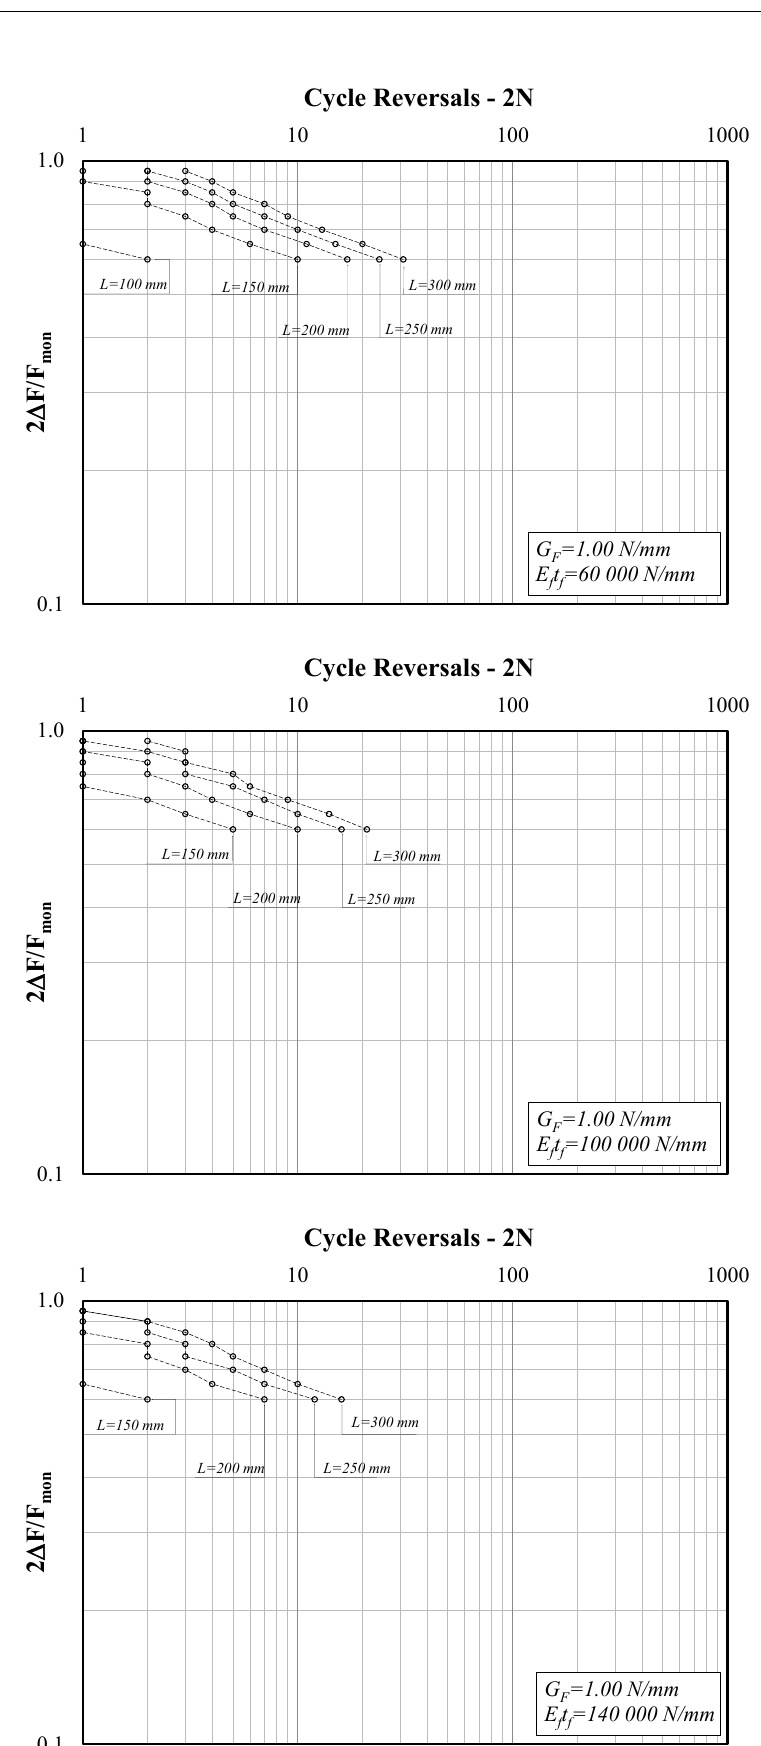
Figure 7. Force amplitude ratio (2 Δ F/F mon ) vs. cycle reversals at debonding (G F = 1.00 N/mm).